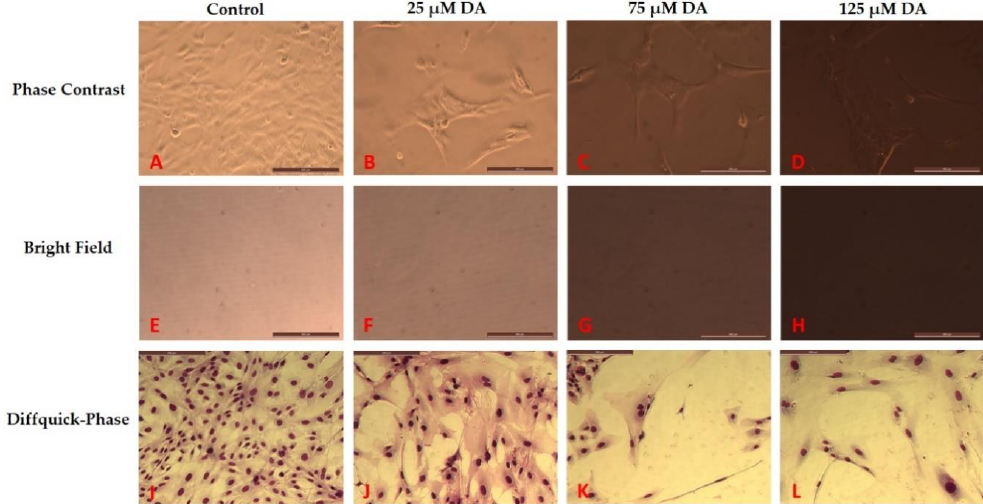
Figure 3. Treatment of 5000 astrocytes / well with dopamine which led to polymerization and formation of polydopamine. Scale bars indicate 200 µm. Panels ( A – D ) show phase contrast images of astrocytes (untreated and treated with dopamine, 48 h post treatment). Panels ( E – H ) show the bright field images of the same fields mentioned in panels ( A – D ). Panels ( I – L ) show the Diffquick stained astrocytes (untreated control and treated with dopamine), 48 h after treatment.